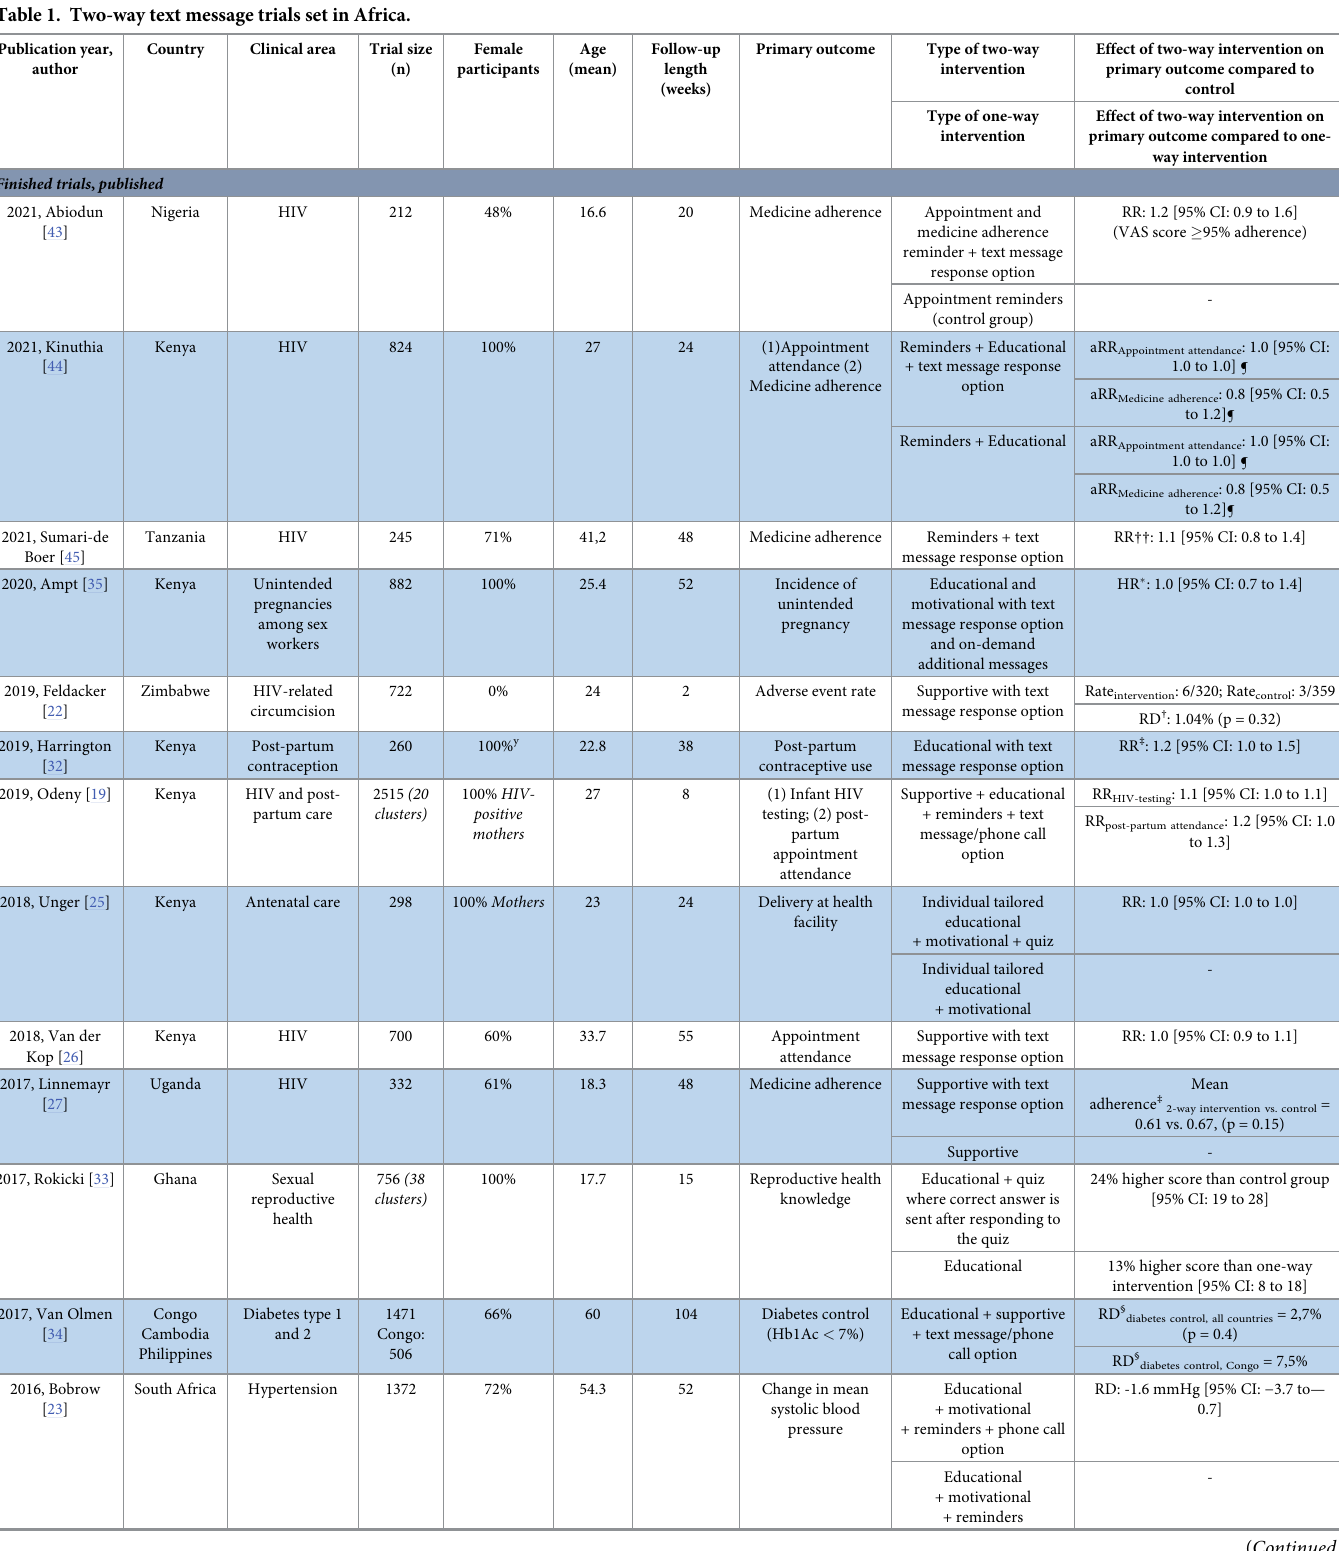
Table 1. Two-way text message trials set in